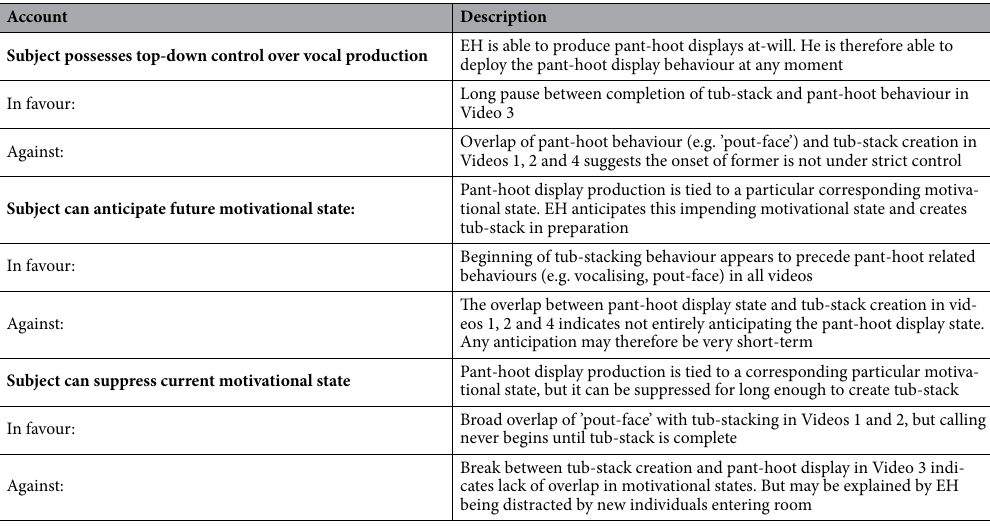
Table 2. Three speculative accounts for the incorporation of tub-stacks into pant-hoot displays. The accounts are non-exhaustive, and not mutually